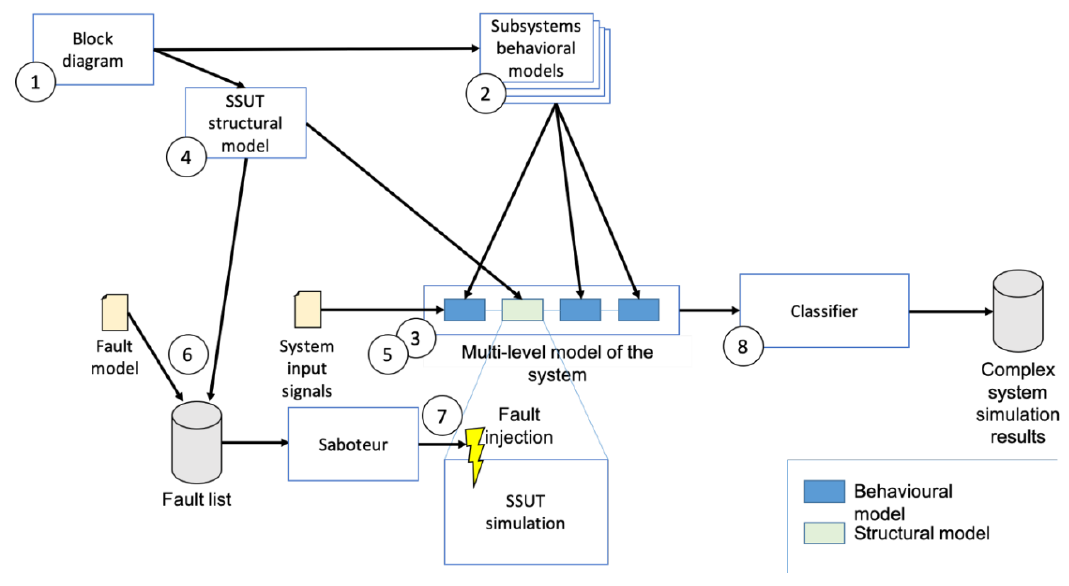
Figure 2. The proposed approach diagram.